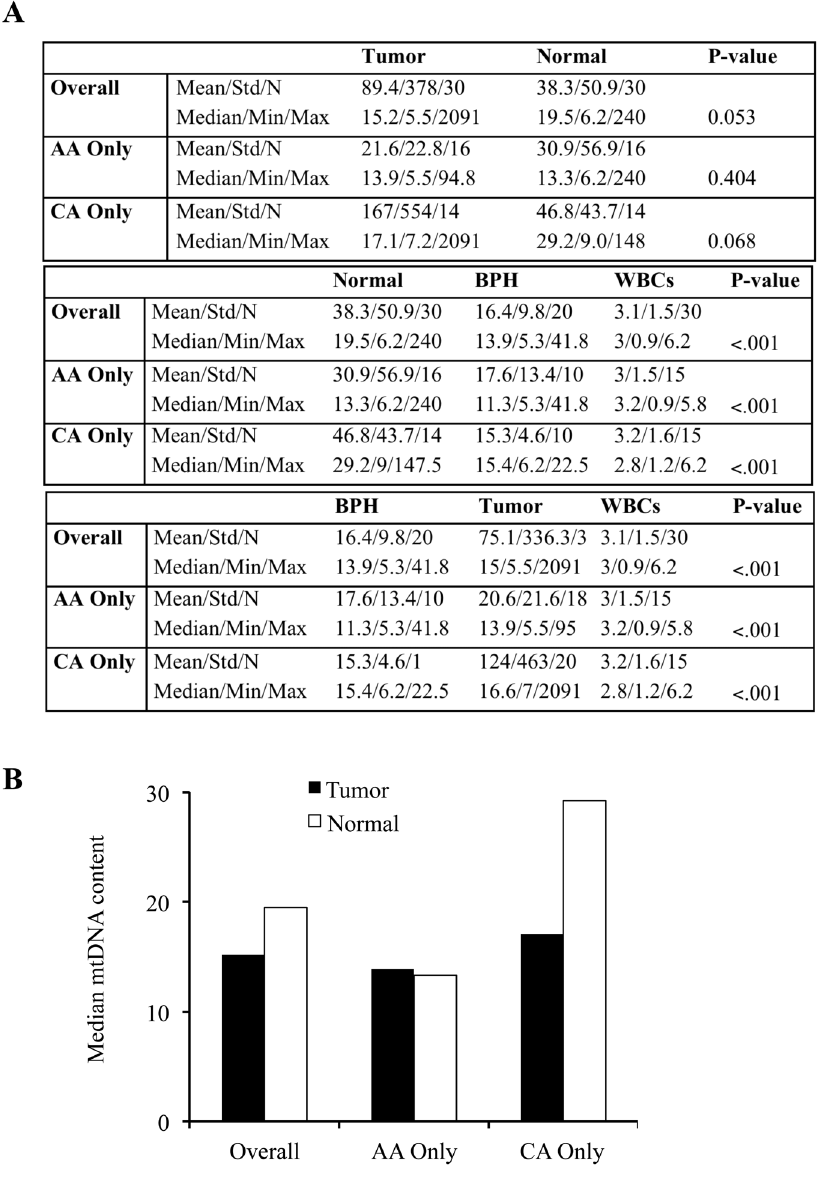
Figure 2. Comparison of mtDNA content in normal, BPH, WBC, and tumors from AA and CA prostate cancer patients. A, Due to paired nature of data, median mtDNA values were compared between tumor and normal samples using Wilcoxon signed-rank tests (top panel of table). Normal, BPH, and WBCs were compared using Kruskal-Wallis tests (middle panel). Tumor, BPH, and WBCs were compared to one another using Kruskal-Wallis tests (lower panel). B, Median mtDNA values from top table of panel A are plotted for